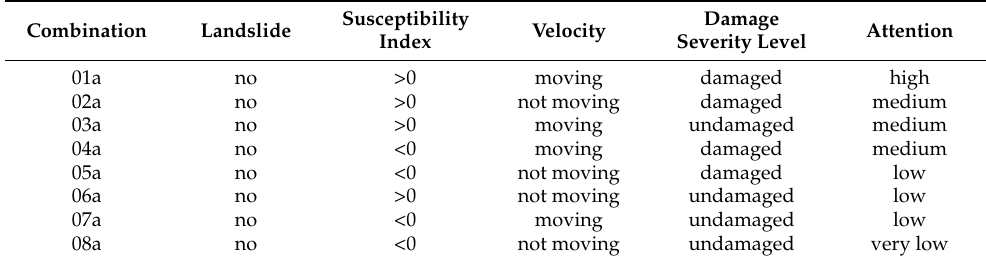
Table 2. Correlation matrix defining the different levels of attention